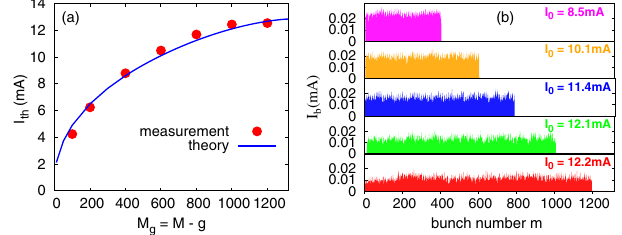
FIG. 6. (a) Vertical coupled-bunch instability threshold I as a th M − g , where g is the gap in the maximal function of M g ¼ ( M ¼ 1320 ) uniform filling pattern: comparison between theory and measurements. The blue trace shows the analytical result obtained by equating the fastest growth time (determined by the eigenvalue with the largest imaginary part) to the radiation 22 . 5 ms; the red dots represent the measured damping time τ y ¼ thresholds, obtained as the arithmetic mean of the currents slightly below and above threshold, as shown in Fig. 5. (b) Bunch trains close to instability threshold as measured from the NSLS-II I 0 =M filling pattern monitor: single bunch current I as a b ¼ g function bunch number m